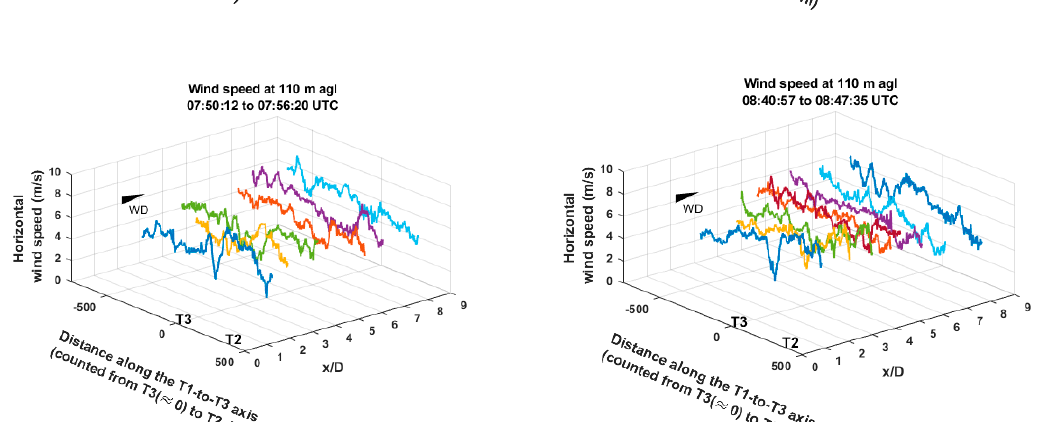
altitudes. The x-axis represents the distance between the UAV and the T1-to-T3 axis normalized by the rotor diameter D (=92 m). The black arrows indicate the wind direction (WD). The remaining axis represents the distance (in m) along the T1-to-T3 axis.